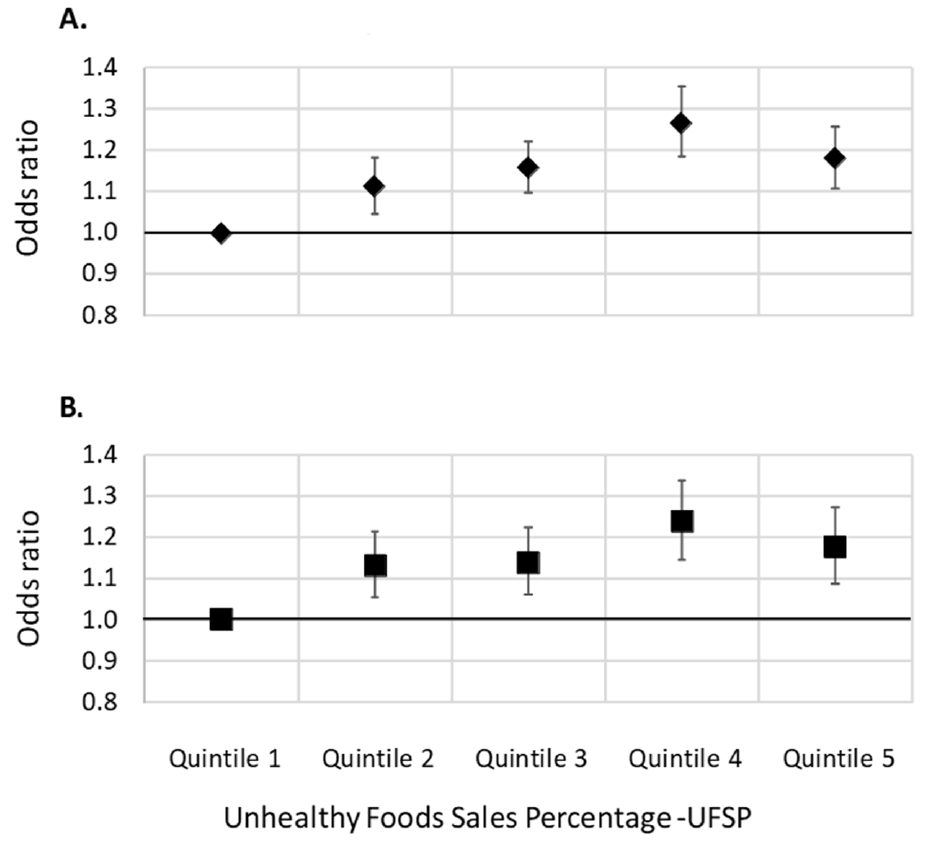
Figure 1. Associations between unhealthy food sales percentage and the odds of being ( A ) overweight (including obese) or ( B ) obese. Odds ratios from logistic regression models (ref = Q 1). Models adjusted for sex, age group, and individual-level physical activity, as well as local-authority-level deprivation and ethnic mix.